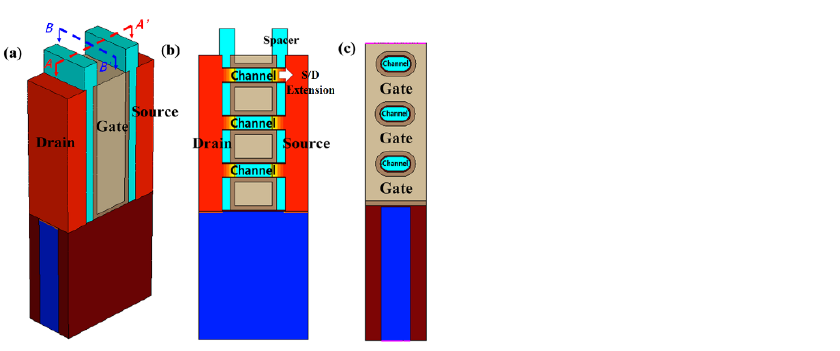
Figure 1. Intrinsic 3 nm nanosheet GAAFET. ( a ) 3D schematic and ( b ) 2D cross-section along AA’ direction and ( c ) BB’ direction.